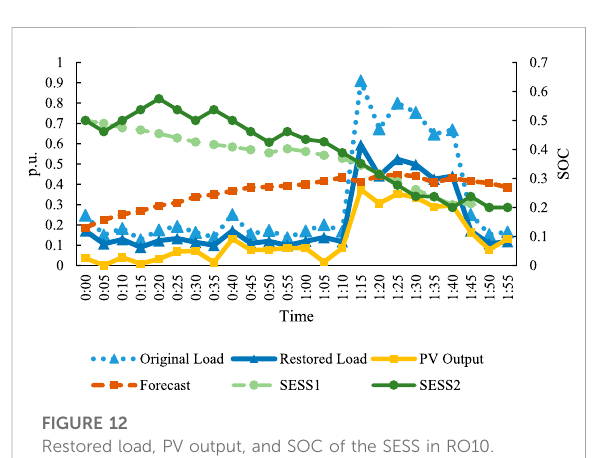
FIGURE 13 SOC result of the MESS in